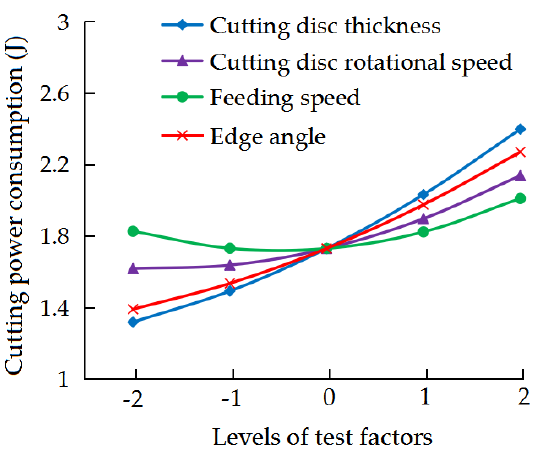
Figure 5. Influence of test factors on cutting power consumption.